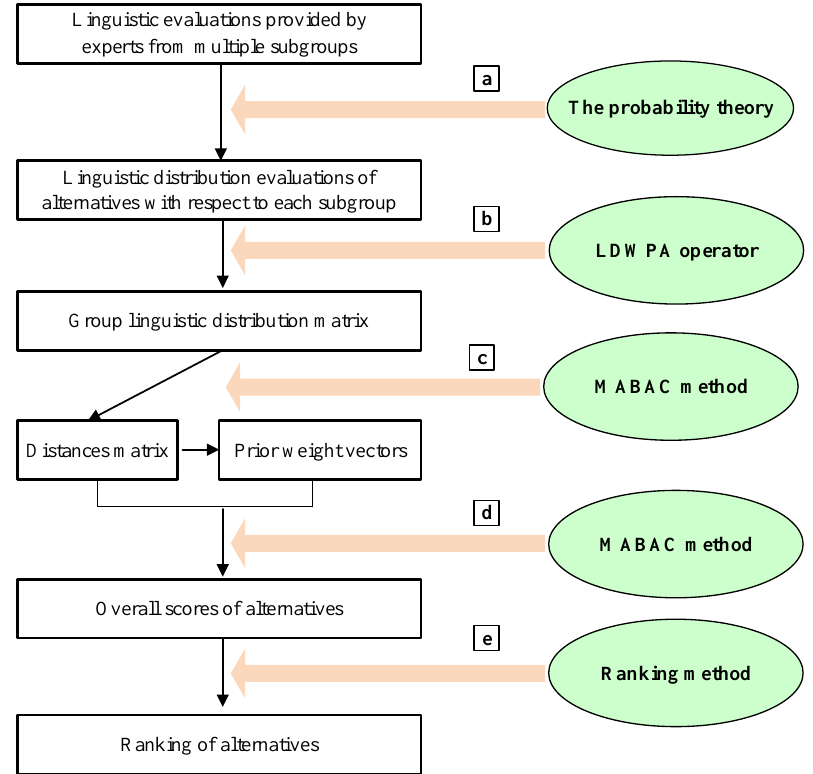
Figure 2. The resolution procedure for the emergency decision problem.